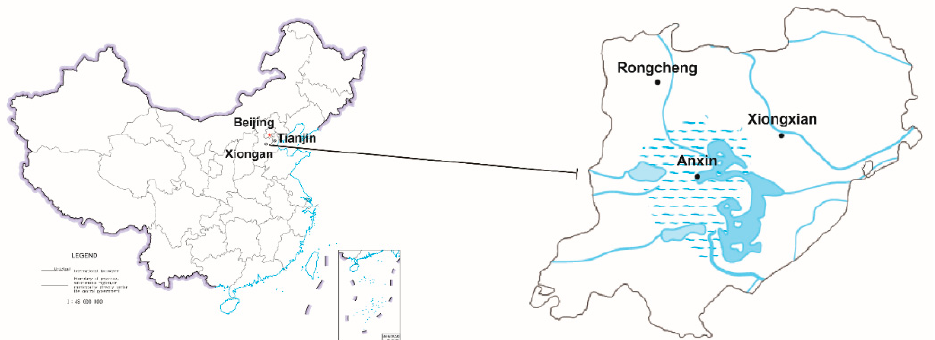
maintenance of natural water and nutrient cycles, and improve human well-being with both spiritual and recreational benefits as a shared space for future citizens (Figure 2a).